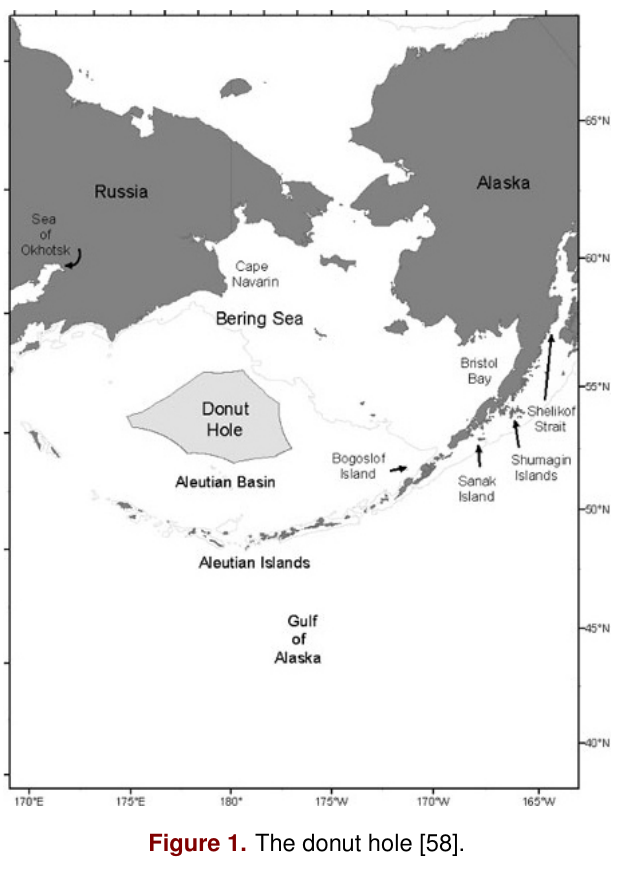
Figure 1. The donut hole